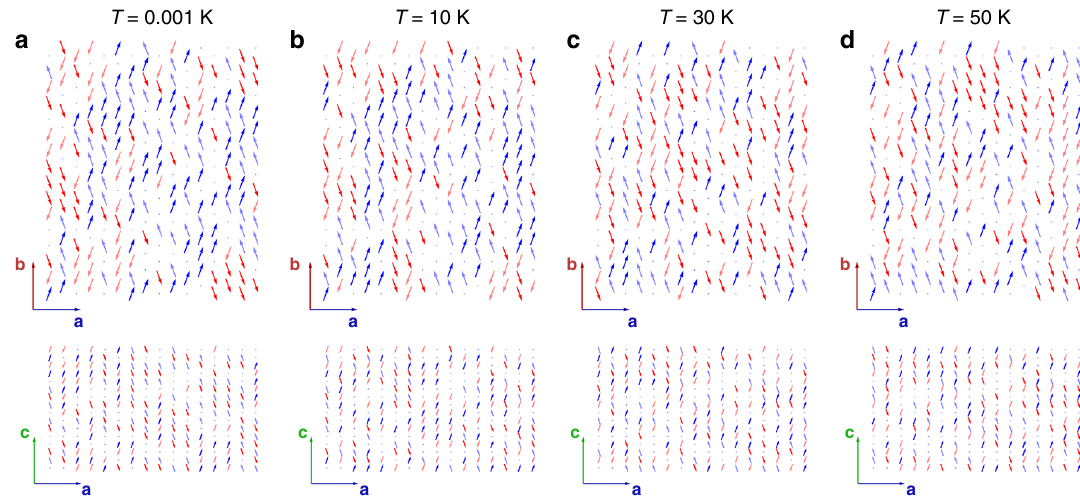
Fig. 6 Con fi guration of water molecular dipoles at different temperatures. We plot the con fi gurations of water molecular dipoles in ab and ac cross sections at different temperatures obtained from Monte Carlo simulations. Red and blue colors correspond to directions parallel (blue) and antiparallel (red) to the b -axis; bright and faded tones correspond to directions along (bright) and against (faded) the a -axis. Since the dipoles lie within the ab -planes and have zero component along the c -axis, arrows in the ac -panels are arti fi cially turned to indicate their directions in the ab -planes. For the analysis, angles of ±20° relative to the b -axis were taken from DFT-MD simulations. Filling factor is 75%.